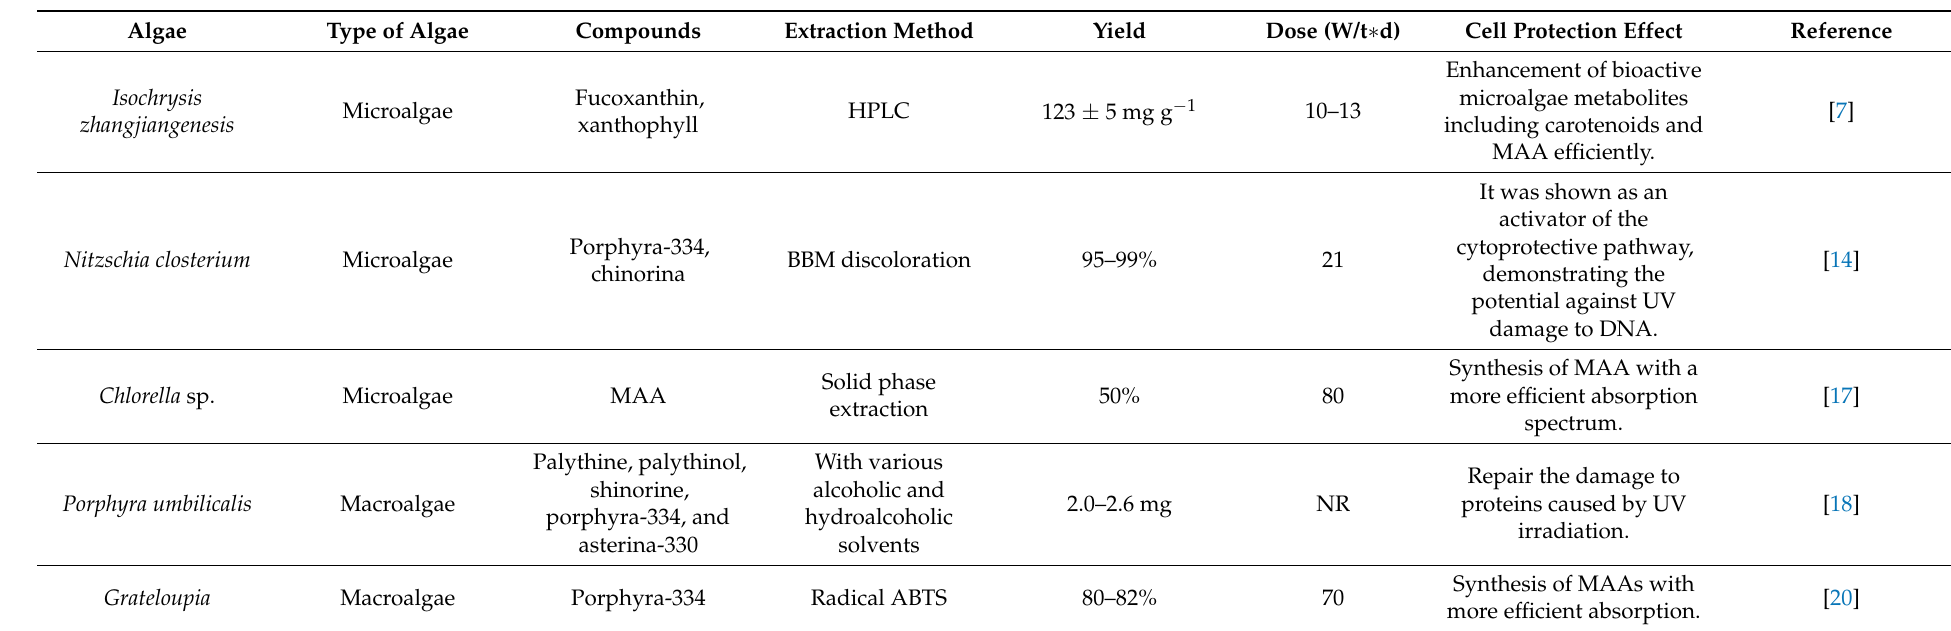
Table 1. Algae compounds obtained by UVA